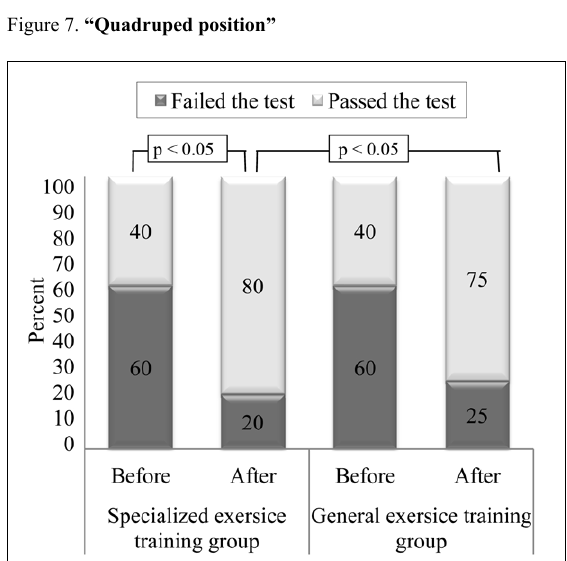
Figure 8. Prone lying active knee flexion